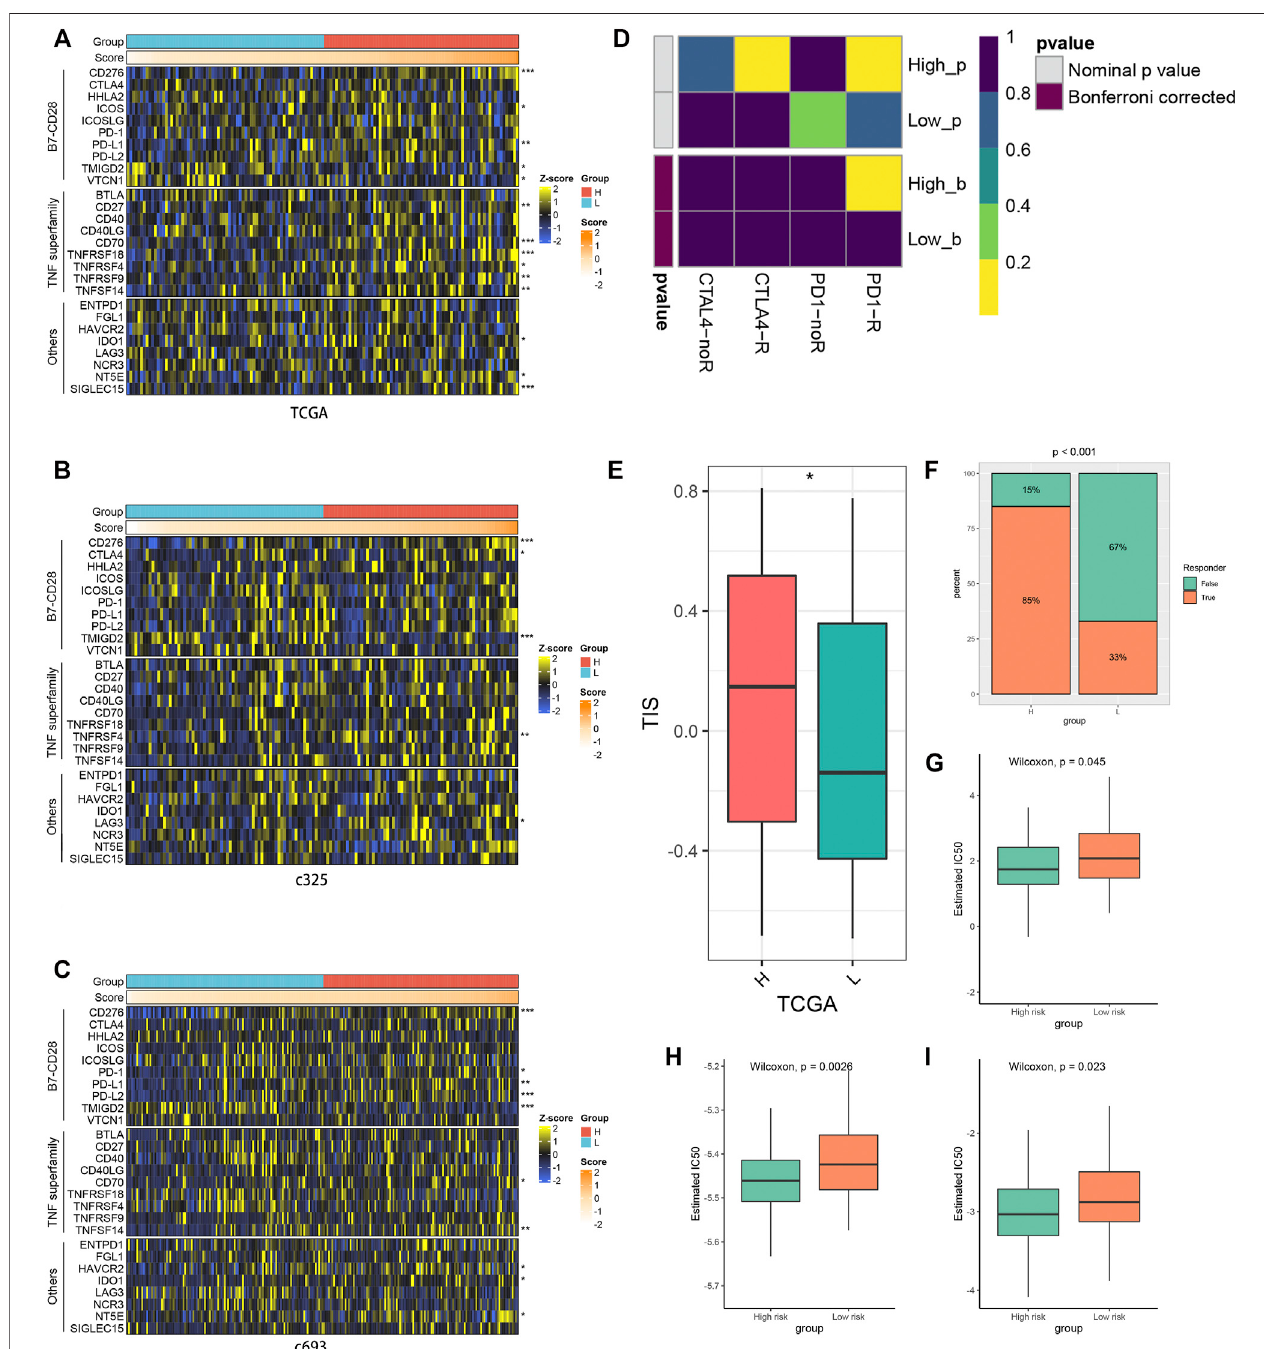
FIGURE7| Evaluationofimmunecheckpointpro fi les,immunotherapy,andchemotherapybetweenriskgroups. (A – C) Threeheatmapsof27immunecheckpoints pro fi les in high-risk and low-risk groups. * p < 0.05, ** p < 0.01, *** p < 0.001. (D) Submap analysis ofthe TCGA cohort and 47 previous melanoma patients with detailed immunotherapeutic information. (E) The distribution difference of T-cell in fl ammatory signature (TIS) score between the high- and low-risk groups. * p < 0.05. (F) Distribution of the immunotherapy response results predicted by the Tumor Immune Dysfunction and Exclusion (TIDE) algorithm among the high- and low-risk groupsintheTCGAcohort. (G – I) Distributionoftheestimatedhalf-maximalinhibitoryconcentration(IC50)ofbleomycin (G) ,docetaxel (H) ,andpaclitaxel (I) betweenthe high- and low-risk groups in TCGA cohort.